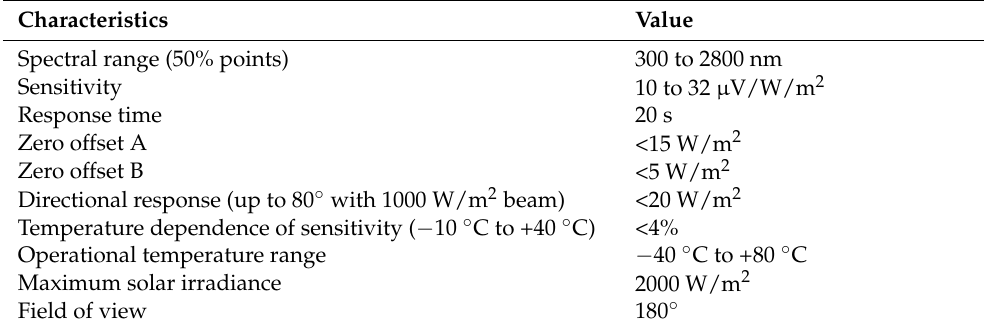
Table 4. Specifications of the CMP and Kipp & Zonen pyranometer (based on the datasheet).